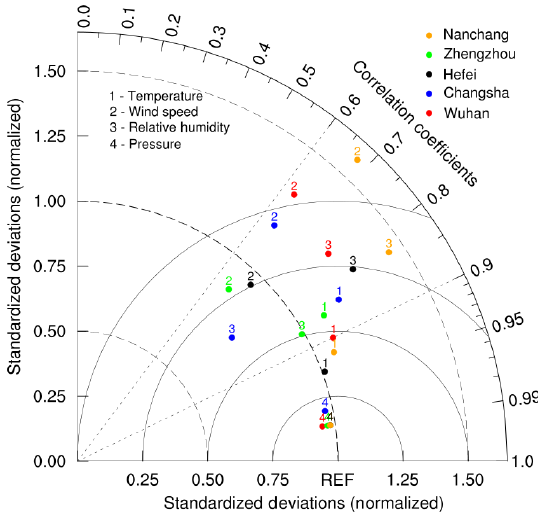
Figure 2. A Taylor plot with the normalized standard deviations and correlation coefficients between WRF-simulated and observed meteorological fields. The radian of the sector represents the cor- relation coefficient. The solid line indicates the ratio of standard deviation between simulations and observations. The distance from the marker to “REF” reflect the normalized root-mean-square error